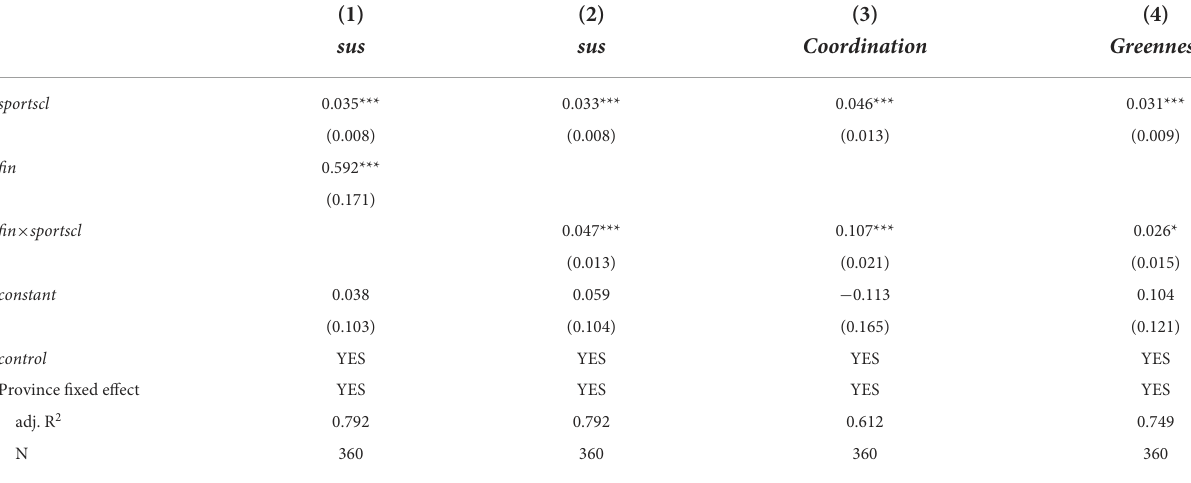
TABLE 9 The regression result of the moderating effect based on the level of development of